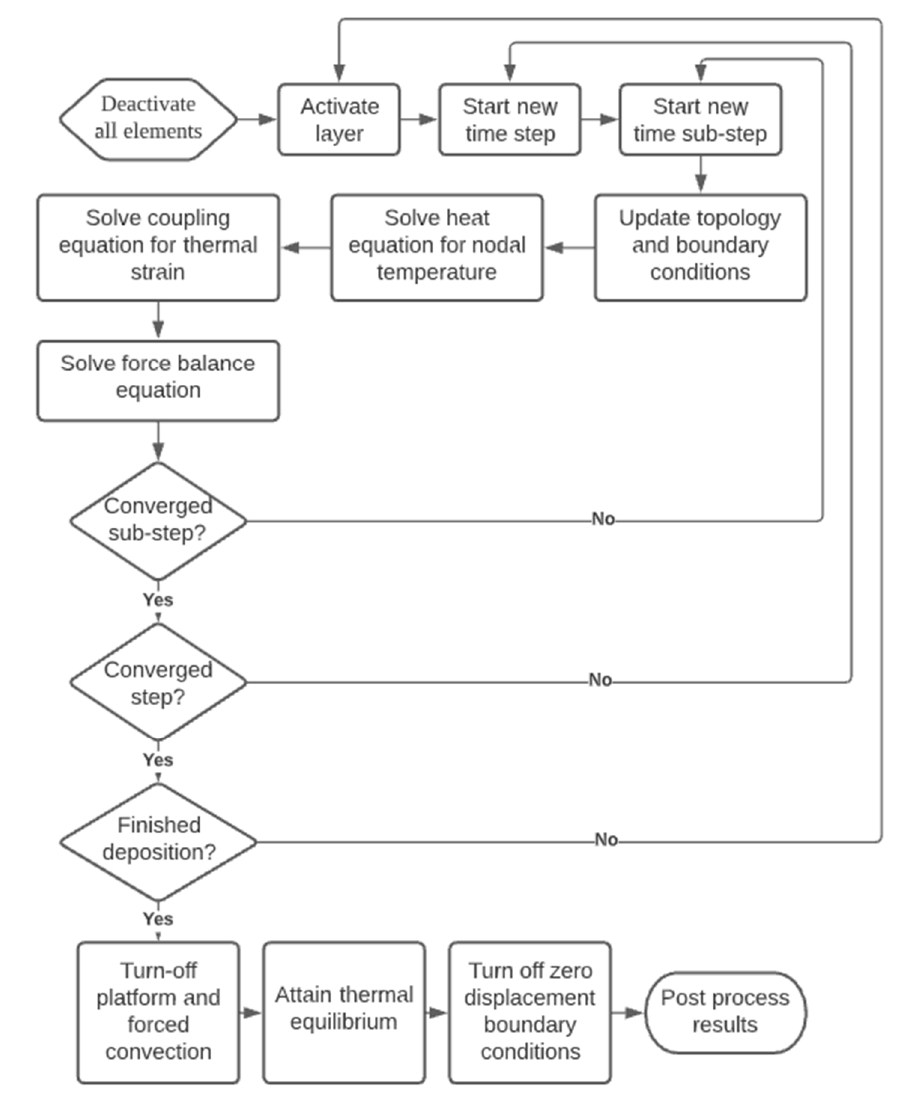
Figure 4. Algorithm used to perform simulations. Table 1. Constant material properties .